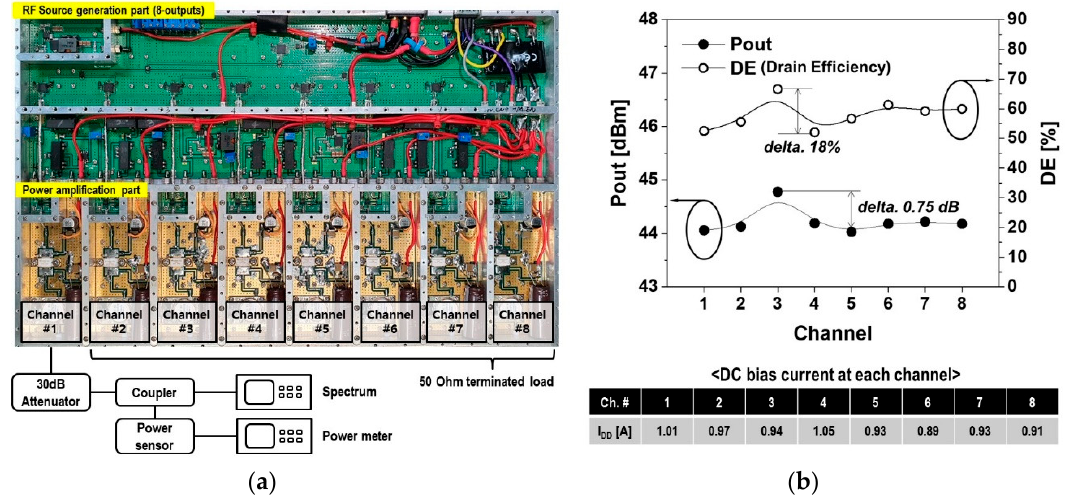
Figure 6. ( a ) A photograph of the proposed module and measurement setup ( b ) the measurement result of each channel.